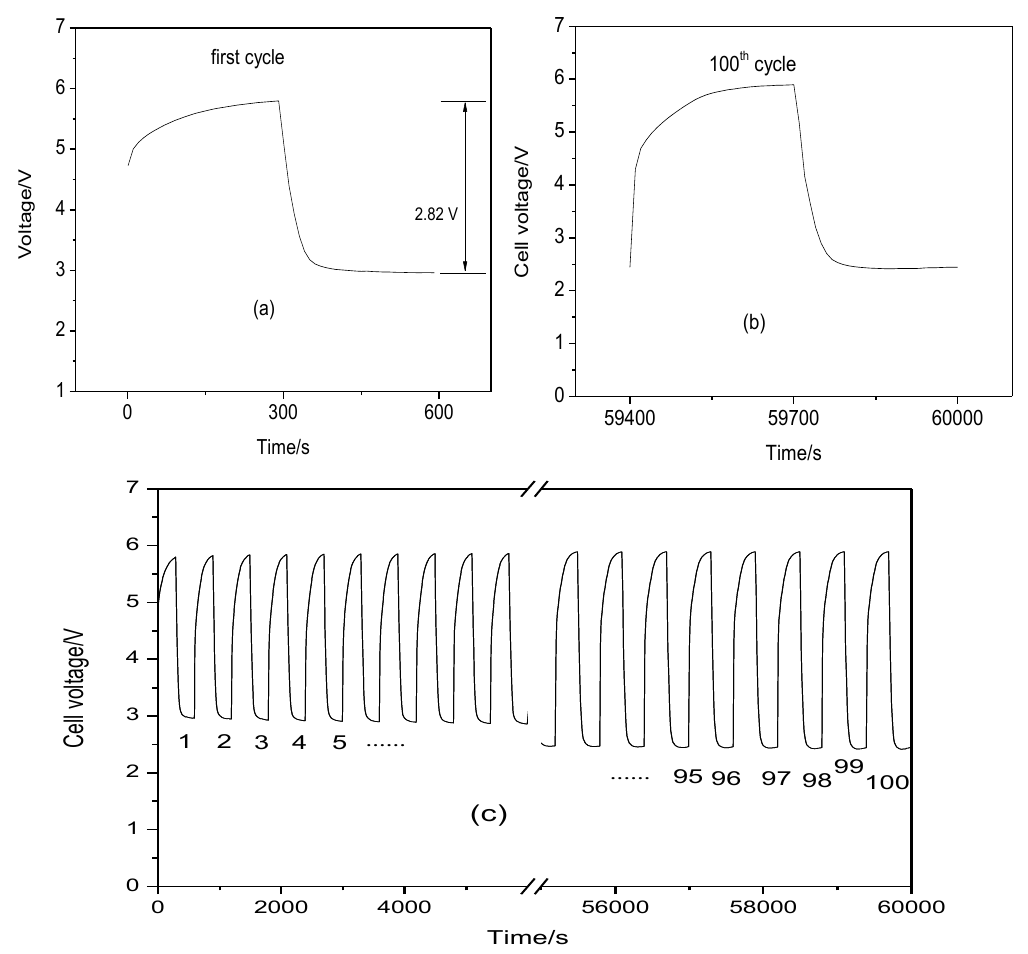
Figure 3. Charge-discharge cycles for the electrically rechargeable three-cell zinc-air battery stack: ( a ) enlargement of the first cycle; ( b ) enlargement of the 100th cycle; ( c ) total cycles 100; charging or discharging for 300 s in each state; current density of 15 mA·cm −2 for the charging process; current density of 25 mA·cm −2 for the discharging